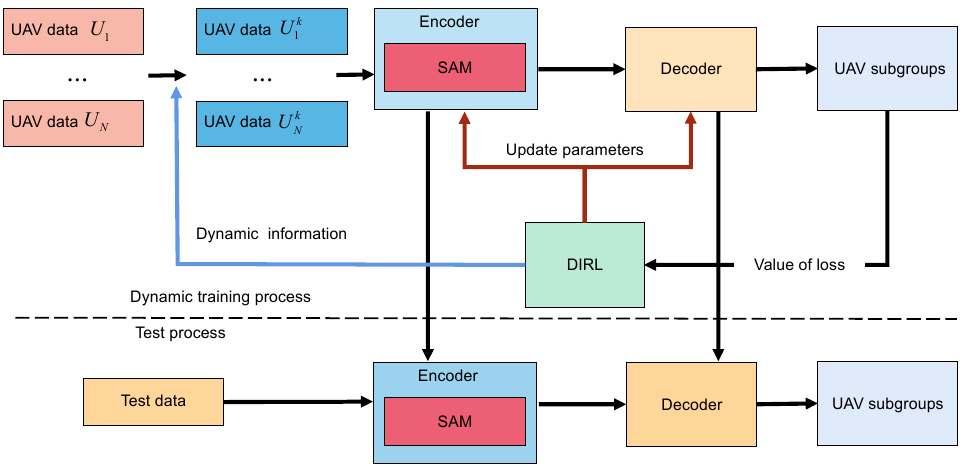
Figure 2. The model structure of DIRL-SAM.